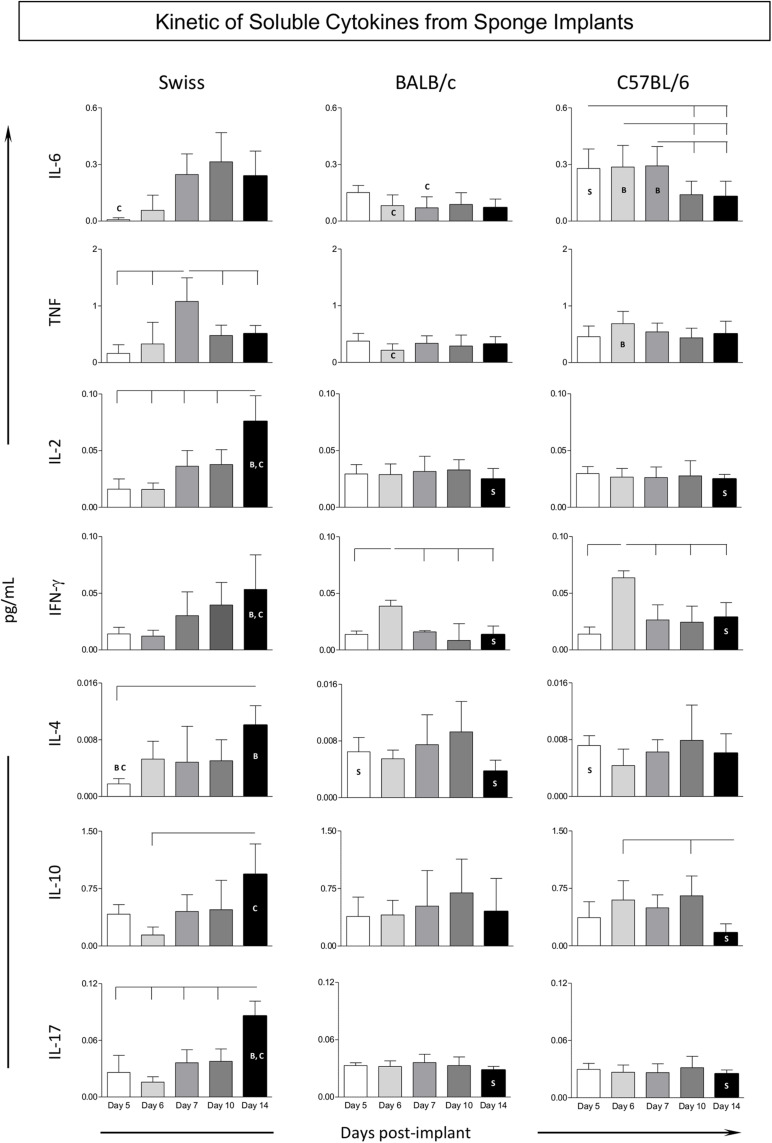
Kinetics of soluble cytokines from sponge implants. The sponge disks were subcutaneously implanted and removed at Day5, Day6, Day7, Day10, and Day14 post-implant. They were homogenized and soluble cytokine levels were measured by Cytometric Bead Array. Data are reported as mean levels (pg/mL) ± standard deviation along the days post-implant. Intragroup and intergroup comparisons were assessed. Significant differences at p < 0.05 are underscored by connecting lines within the lineage and by letters “S,” “B,” and “C” for comparisons with Swiss, BALB/c, or C57BL/6 mice, respectively.